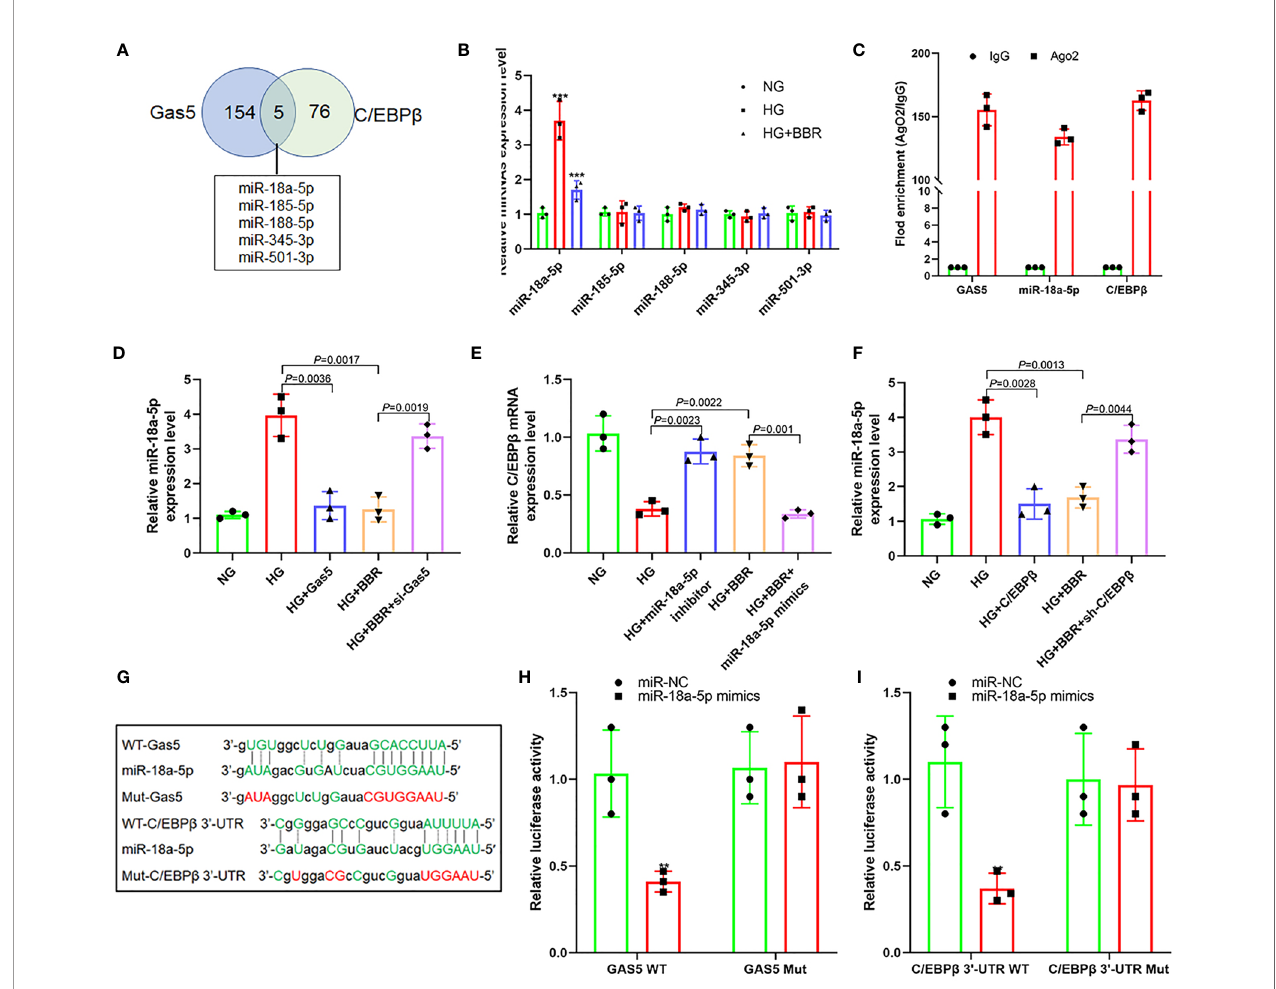
FIGURE 6 | Gas5 regulated the expression of miR-18a-5p and C/EBP b as ceRNA. (A) Five miRNAs that can simultaneously bind with Gas5 and C/EBP b 3 ′ -UTR, and the intersection is shown as a Venn plot. (B) Effect of BBR on the expression of fi ve miRNAs in HK-2 cells under HG condition (***P < 0.001). (C) RIP assay was used for detection of the enrichment of miR-18a-5p, Gas5, and C/EBP b in response to anti-Ago2 compared to the negative control IgG. (D) Effect of HG and Gas5 on the expression of miR-18a-5p. (E) Effect of miR-18a-5p on the C/EBP b mRNA expression. (F) Effect of C/EBP b on the miR-18a-5p expression. (G) Binding sites of miR- 18a-5p, Gas5, and C/EBP b 3 ′ -UTR and construction of plasmids. (H) Targeting effect of miR-18a-5p and Gas5 (**P < 0.01). (I) Targeting effect of miR-18a-5p and C/EBP b 3 ′ -UTR (**P <